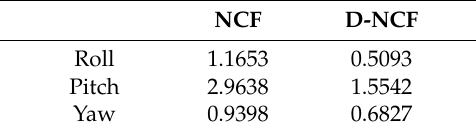
Table 3. Attitude estimation error of NCF and D-NCF algorithm in roll, pitch and